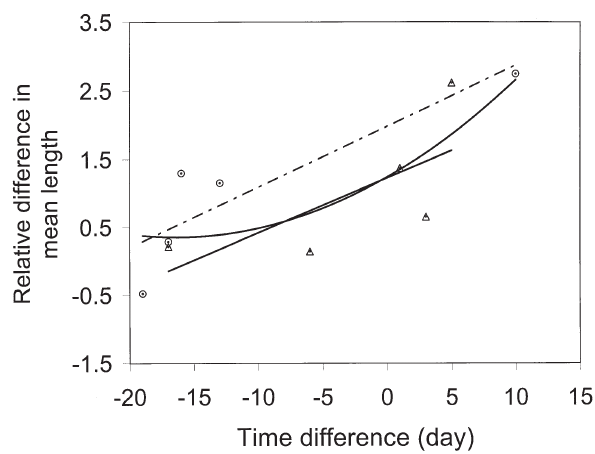
F IG . 3. – Relative difference in mean lengths versus time differ- ence in day (GRUND-GRUND and MEDITS-MEDITS) of the first normal component in the sizes of Phycis blennoides . Circles and triangles denote MEDITS and GRUND surveys. The fitted straight line refers to MEDITS (dotted; r= 0.88) and GRUND (solid; r= 0.70) data; the parabolic relationship (r= 0.77) refers to